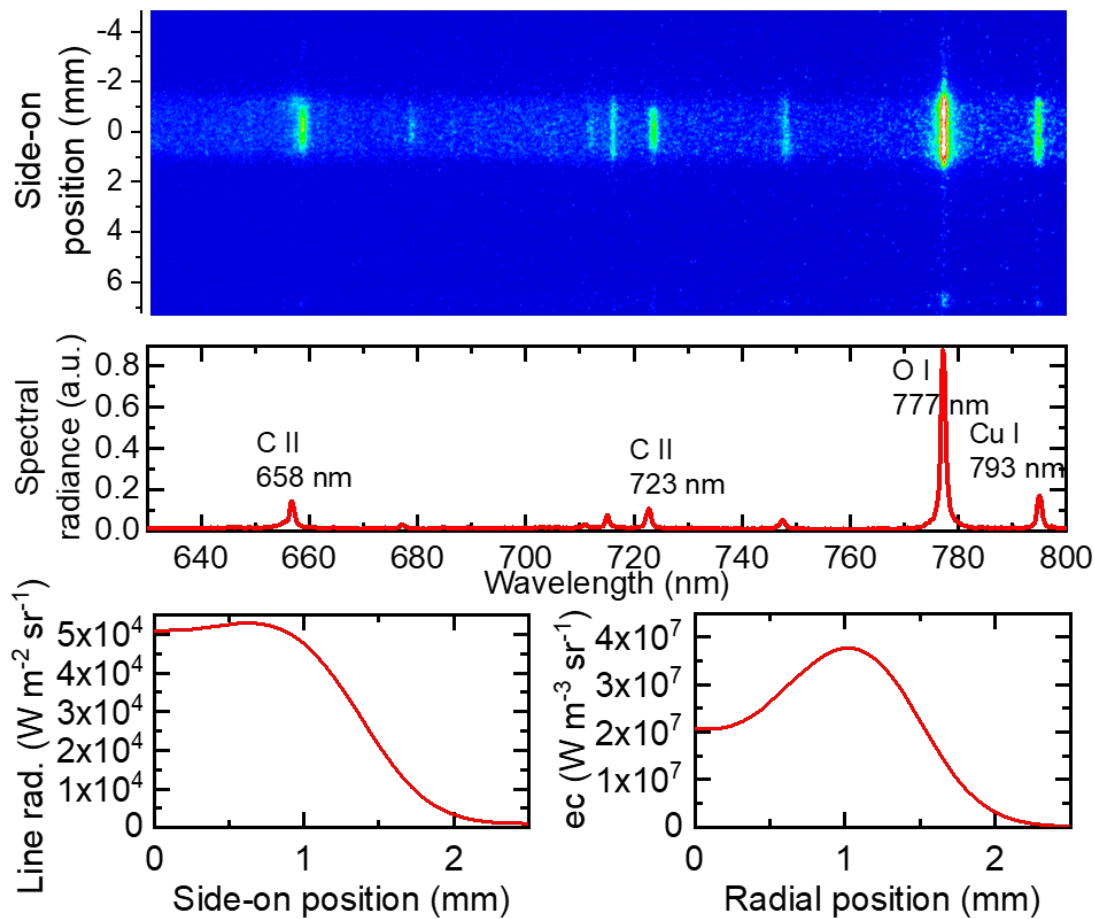
Figure 7. Two-dimensional spectrum measured 300 µ s before CZ by an intensified CCD (ICCD) camera to gain higher sensitivity in comparison to HSC ( top ). Vertical axis comprises of a nozzle diameter of 12mm. After shifting the axis to the central position of the arc and symmetrization, side-on radiance was obtained by integration over the O I 777nm triplet ( bottom left ). The deduced emission coefficient ( bottom right ) shows a distinct maximum at 1mm caused by the higher ionization degree in the arc